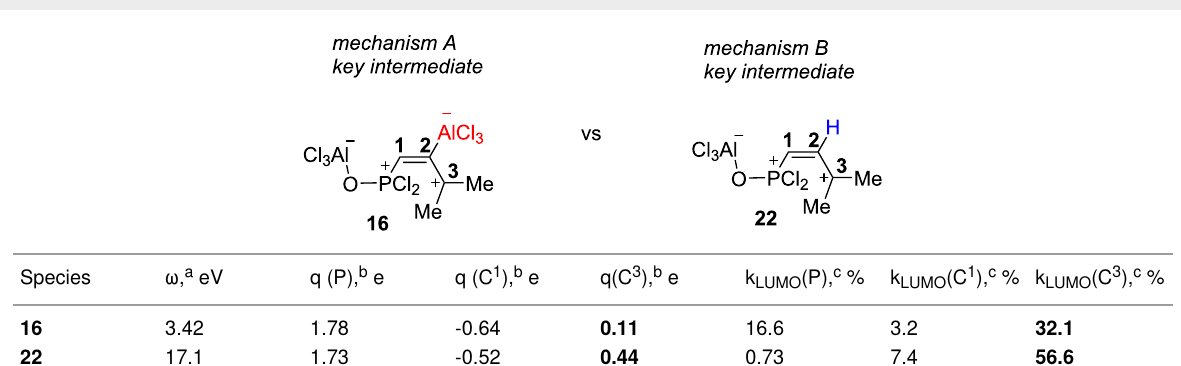
Table 4: Comparison of selected electronic characteristics of species 16 (mechanism A) and species 22 (mechanism B) derived from allene 1a .